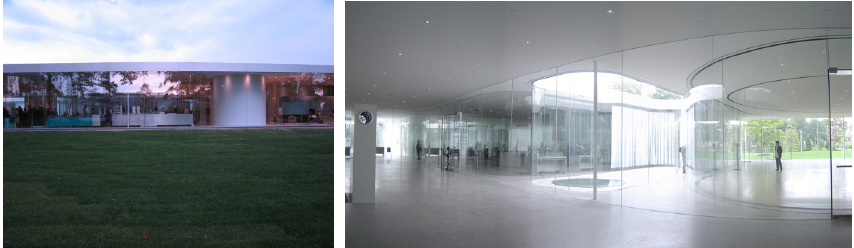
Figure 11a, b: Exterior View, Interior